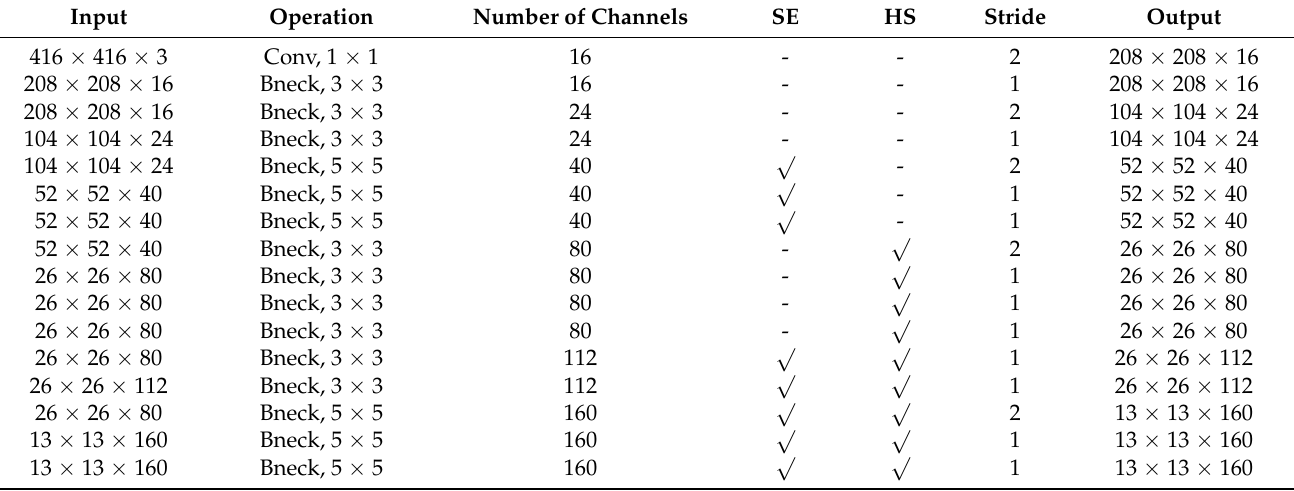
Table 1. MobileNetv3 network